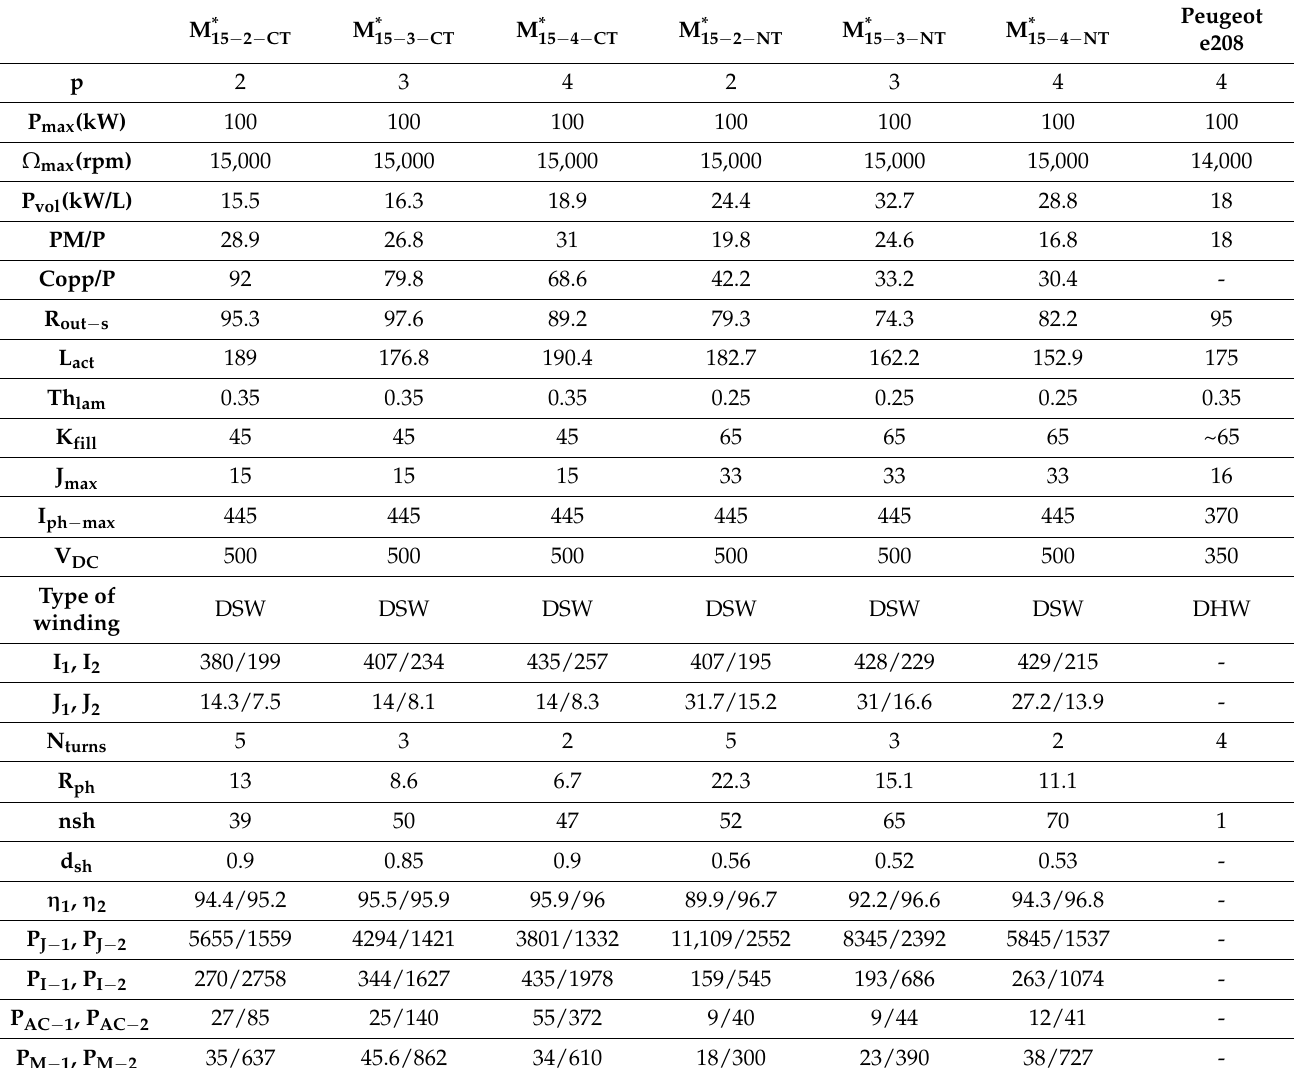
Table 5. Performances and characteristics of optimal machines operating at Ω max = 15,000 rpm and machine used in Peugeot